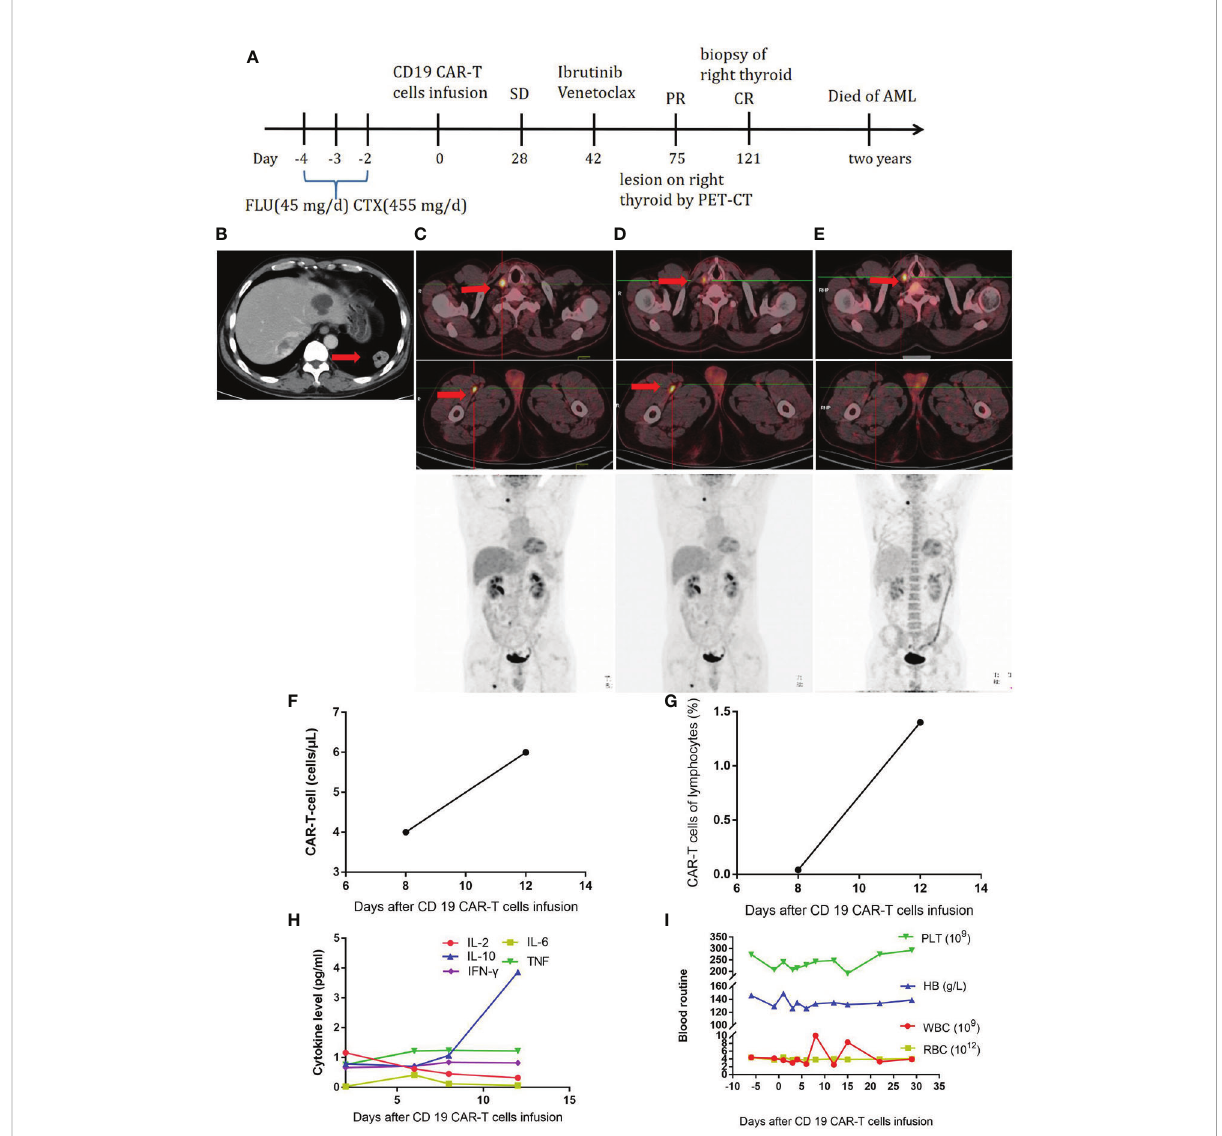
FIGURE 3 (A) , Timeline of the treatment process. (B) , CT at relapse after autologous stem cell transplantation. (C), PET-CT before CAR-T-cell therapy. (D) , PET-CT twenty-eight days after CAR-T-cell therapy. (E) , PET-CT one and half months after ibrutinib and venetoclax treatment. (F) , CAR-T-cell expansion after CAR-T-cell infusion. (G) , Percentage of CAR-T cells in lymphocytes after CAR-T-cell infusion. (H) , Cytokine levels after CAR-T- cell infusion. (I) , Routine blood examination before and after CAR-T-cell